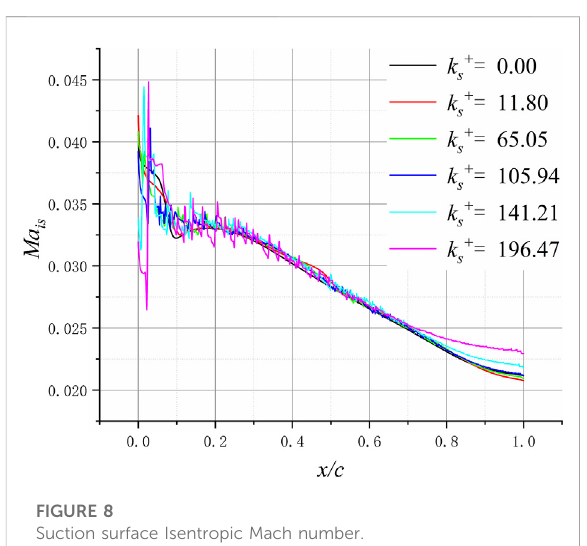
FIGURE 8 Suction surface Isentropic Mach